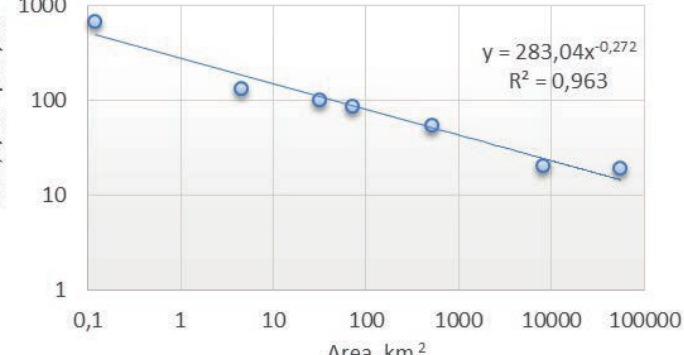
Fig. 2 The relationship between specific sediment yield (SSY) and catchment area for the Srednerusskaya Upland.